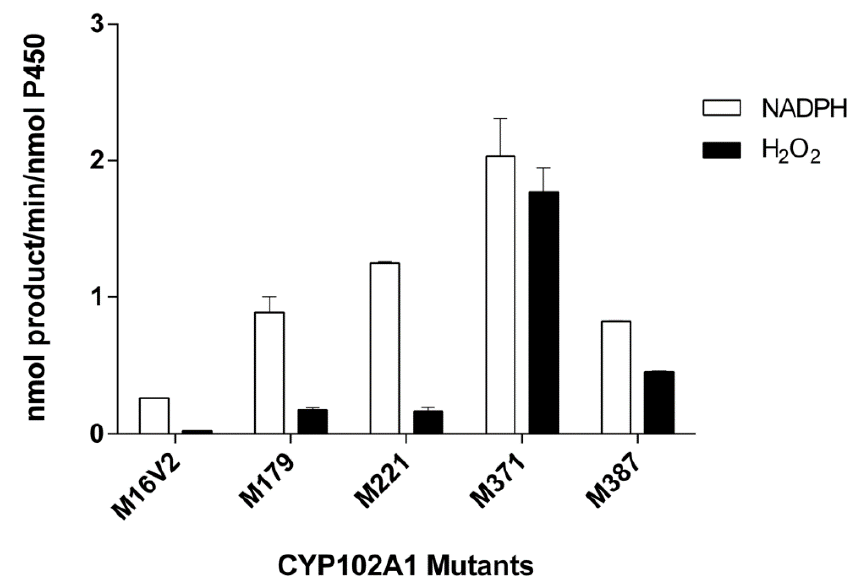
Figure 2. Activity of atorvastatin 4-hydroxylation catalyzed by CYP102A1 mutants. The reaction mixtures included atorvastatin substrate (200 µ M) and 0.20 µ M of CYP102A1 in 100 mM of a potassium phosphate buffer (pH 7.4). For NADPH-supported reactions, an NADPH-generating system was used to initiate the reaction, which was incubated for 30 min at 37 °C. For H 2 O 2 supported reactions, 10 mM H 2 O 2 was used to initiate the reaction, which was incubated for 10 min at 37 °C. The mutants M179, M221, M371, and M387 showed 7.5-fold, 7.1-fold, 76.6-fold, and 19.5-fold higher rates of 4-OH atorvastatin formation than M16V2, respectively, when